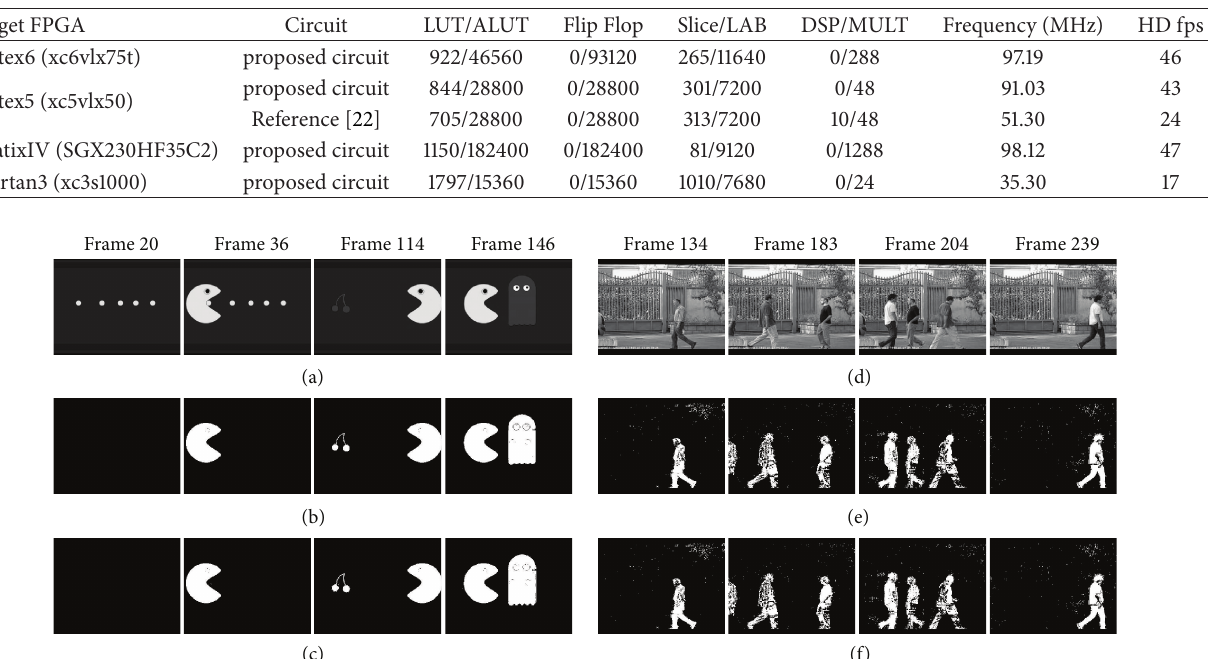
Table 1: Performances of the circuit of Figure 2 implemented on different FPGA and comparison with previous art.